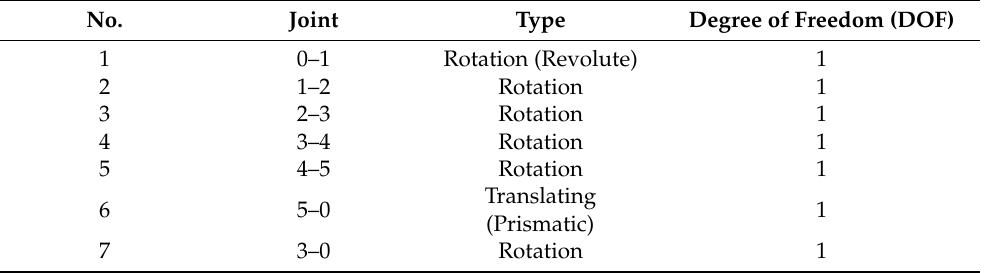
Table 3. Joint identification for the mechanism in Figure